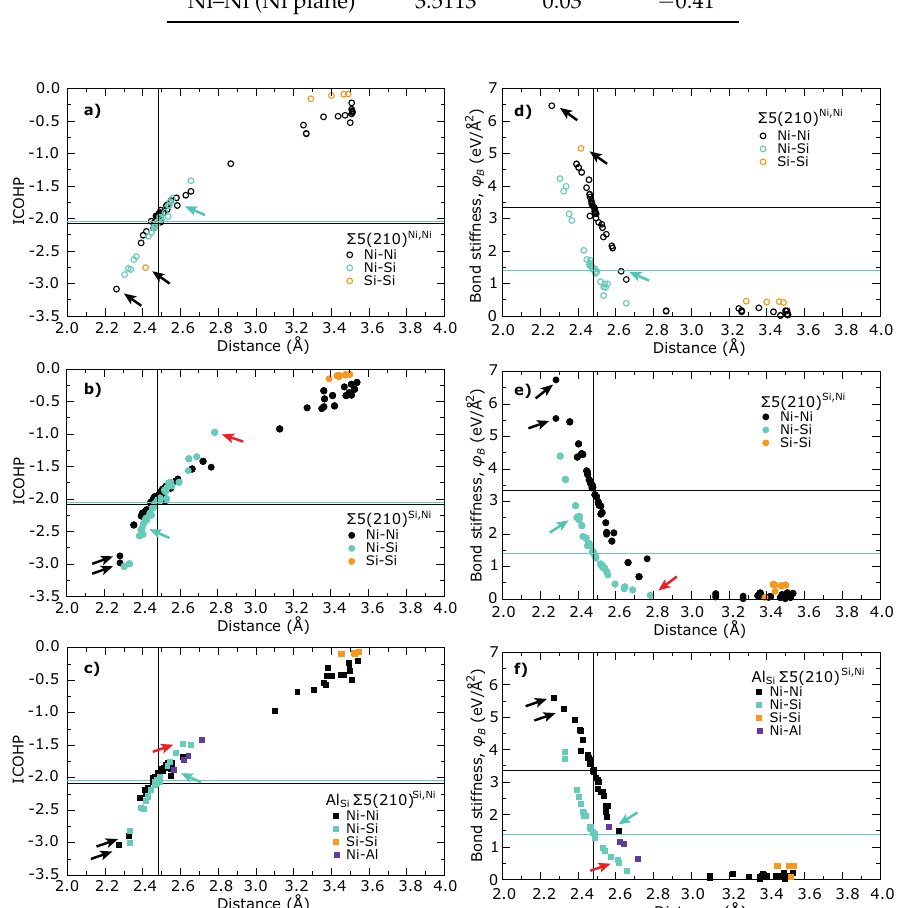
Figure 7. Left column: Integral of COHP up to the Fermi level as a function of the bond length for ( a ) Σ 5(210) Ni,Ni GB, ( b ) Σ 5(210) Si,Ni GB and ( c ) Σ 5(210) Si,Ni GB with Al. Black solid lines correspond to values for nearest neighbors Ni–Ni bond in the bulk Ni 3 Si, whereas cyan solid lines represent Ni–Si bond. Right column: Projected force constant ϕ B (bond stiffness) as a function of the bond length for ( d ) Σ 5(210) Ni,Ni GB, ( e ) Σ 5(210) Si,Ni GB and ( f ) Σ 5(210) Si,Ni GB with Al. Black solid lines correspond to values for nearest neighbors Ni–Ni bond in bulk Ni 3 Si, whereas cyan solid lines represent Ni–Si bond. Arrows mark inter-atomic bonds discussed in